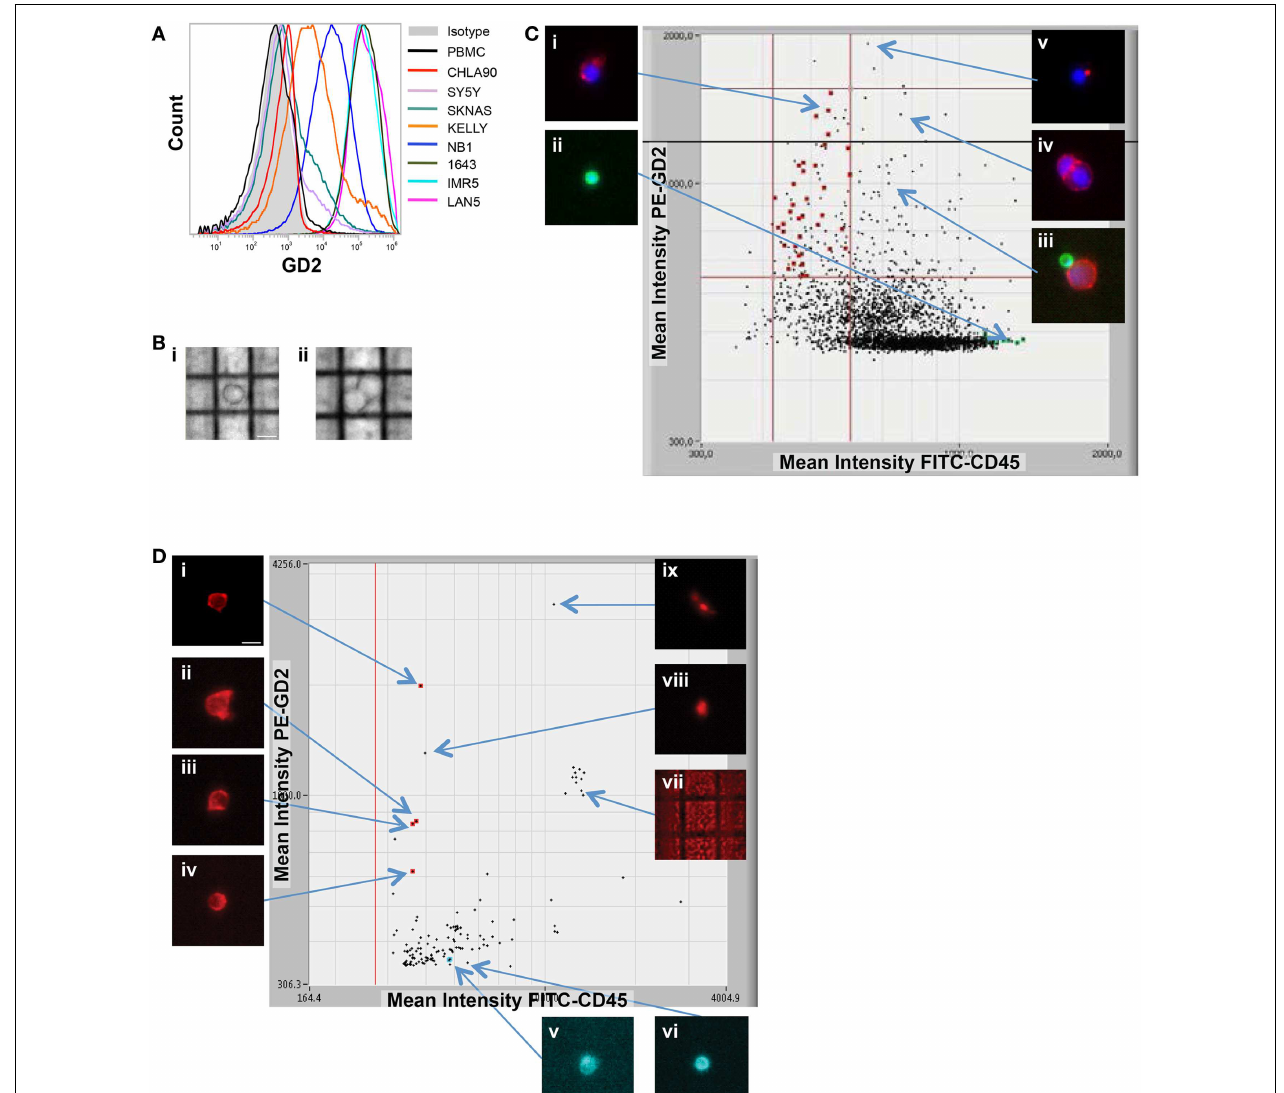
as cell images, including on the left-hand side of the dot-plot (i) an image of a single tumor cell and (ii) a singleWBC, and on the right-hand side (iii) a heterogeneous cluster, (iv) a homogeneous cluster, and (v) a spurious event. (D) NB1643M cells and normal donorWBCs were mixed at a ratio of 1:1,000,000 and stained with GD2-PE and CD45-FITC, in this representative experiment.The sample was pre-enriched using FACSAria-based sorting, and the enriched fraction placed into the DEPArray cartridge. Shown are a scatter plot of GD2-PE and CD45-FITC MFI, as well as images of (i–iv) intact tumor cells, (v and vi)WBCs, and (vii–ix) debris and false-positive